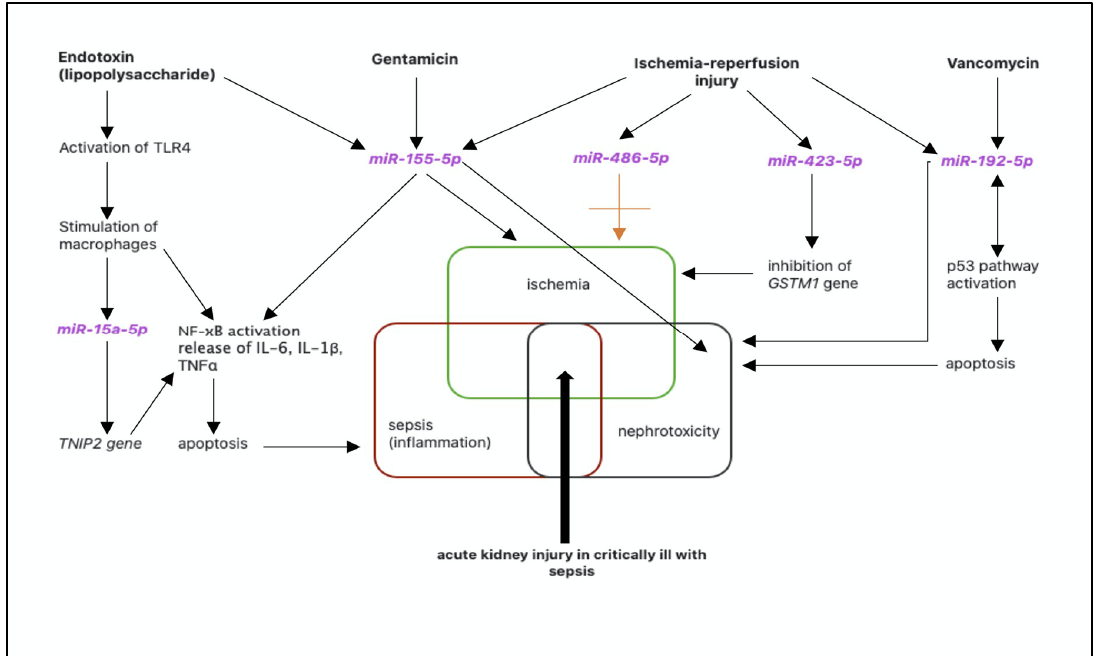
Figure2. Schematicpathophysiologyofacutekidneyinjuryinacriticallyillpatientwithsepsisandnephrotoxic Figure 2. Schematic pathophysiology of acute kidney injury in a critically ill patient with sepsis and nephrotoxic antibiotic treatment with selected miRNAs. AKI—acute kidney injury, GSTM1 — antibiotic treatment with selected miRNAs. AKI—acute kidney injury, GSTM1 —glutathione-S-transferase Mu glutathione-S-transferase Mu 1 gene, IL-6—interleukin 6, IL-1ß—interleukin 1ß, NF-κB—nuclear 1 gene, IL-6—interleukin 6, IL-1ß—interleukin 1ß, NF- κ B—nuclear factor—kappa B, TNF α —tumor necrosis factor—kappa B, TNFα—tumor necrosis factor alpha, TNIP2 —tumor necrosis factor alpha induced factor alpha, TNIP2 —tumor necrosis factor alpha induced protein 3-interacting protein 2, protein 3-interacting protein 2, TLR4—Toll-like receptor 4.